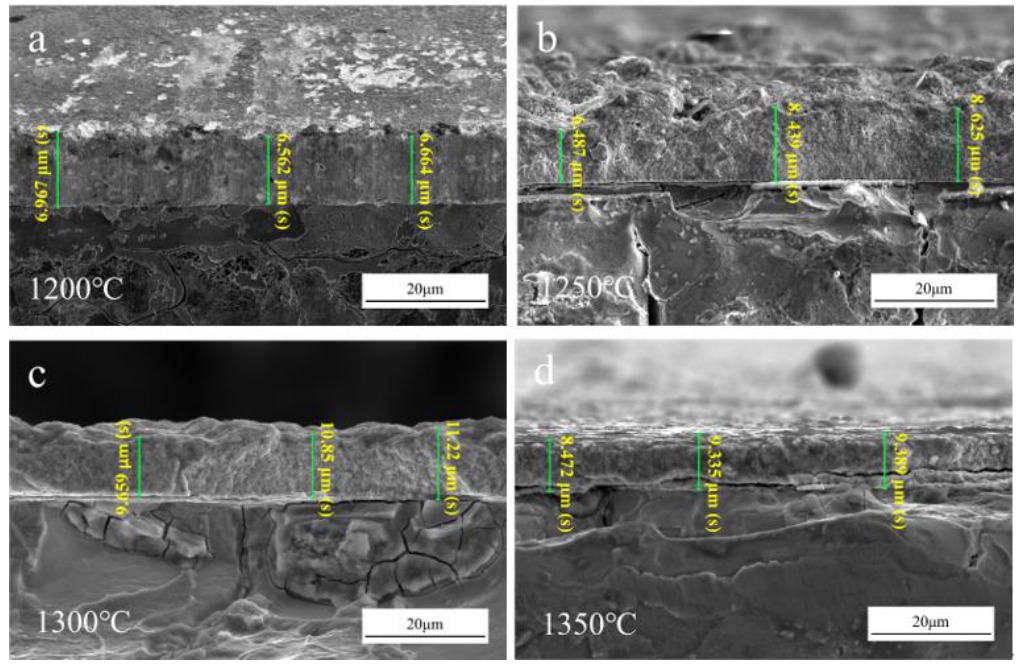
Fig. 5. Thickness of HfO coatings prepared at different deposition temperatures. Figure 5. Thickness of HfO 2 coatings prepared at different deposition temperatures. ( a ) 1200 ◦ C, 2 ( b ) 1250 ◦ C, ( c ) 1300 ◦ C, and ( d ) 1350 ◦